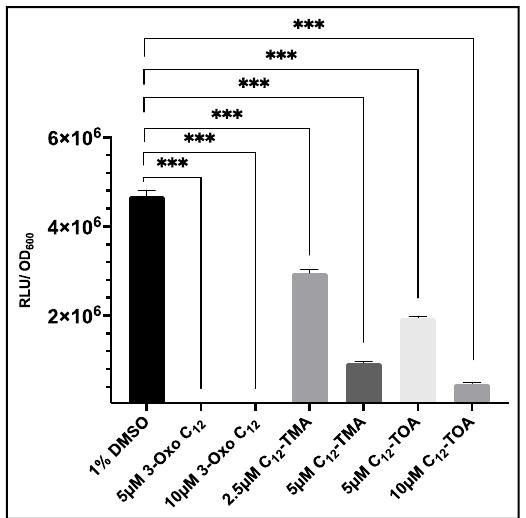
Figure 7. The effect of 3 ‐ oxo ‐ C 12 ‐ HSL, C 12 ‐ TMA and C 12 ‐ TOA on agrP3 ‐ GLuc expression in USA300 agrP3 GLuc. For 3 ‐ oxo ‐ C 12 ‐ HSL, low luminescence values of 1.9 × 10 4 RLU/OD600 (5 μ M) and 2.45 × 10 4 RLU/OD 600 (10 μ M) were recorded. The data show the means with error bars displaying standard deviation of triplicate technical repeats and are representative of biological triplicate repeats. *** p < 0.0001.